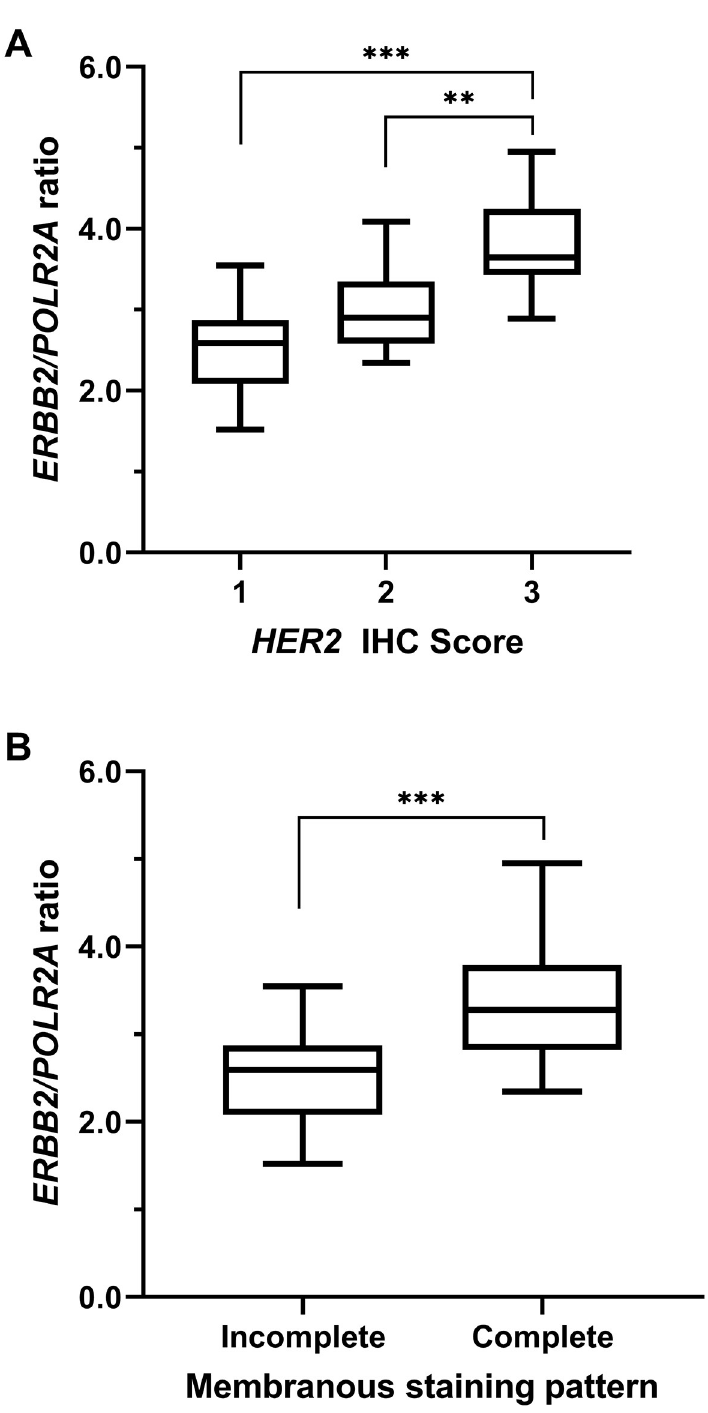
Fig 5. Comparison of the ERBB2/POLR2A ISH ratio according to HER2 IHC score in canine mammary tissues. A significant correlation between the HER2 IHC score and ERBB2/POLR2A ISH ratio was observed ( �� , P < 0.01; ��� , P <